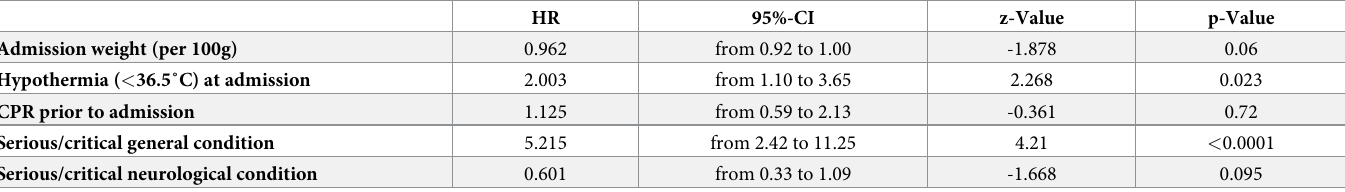
Table 8. Hazard Ratio (HR) estimates from the cause-specific Cox proportional-hazards model on time to death with admission characteristics as explanatory